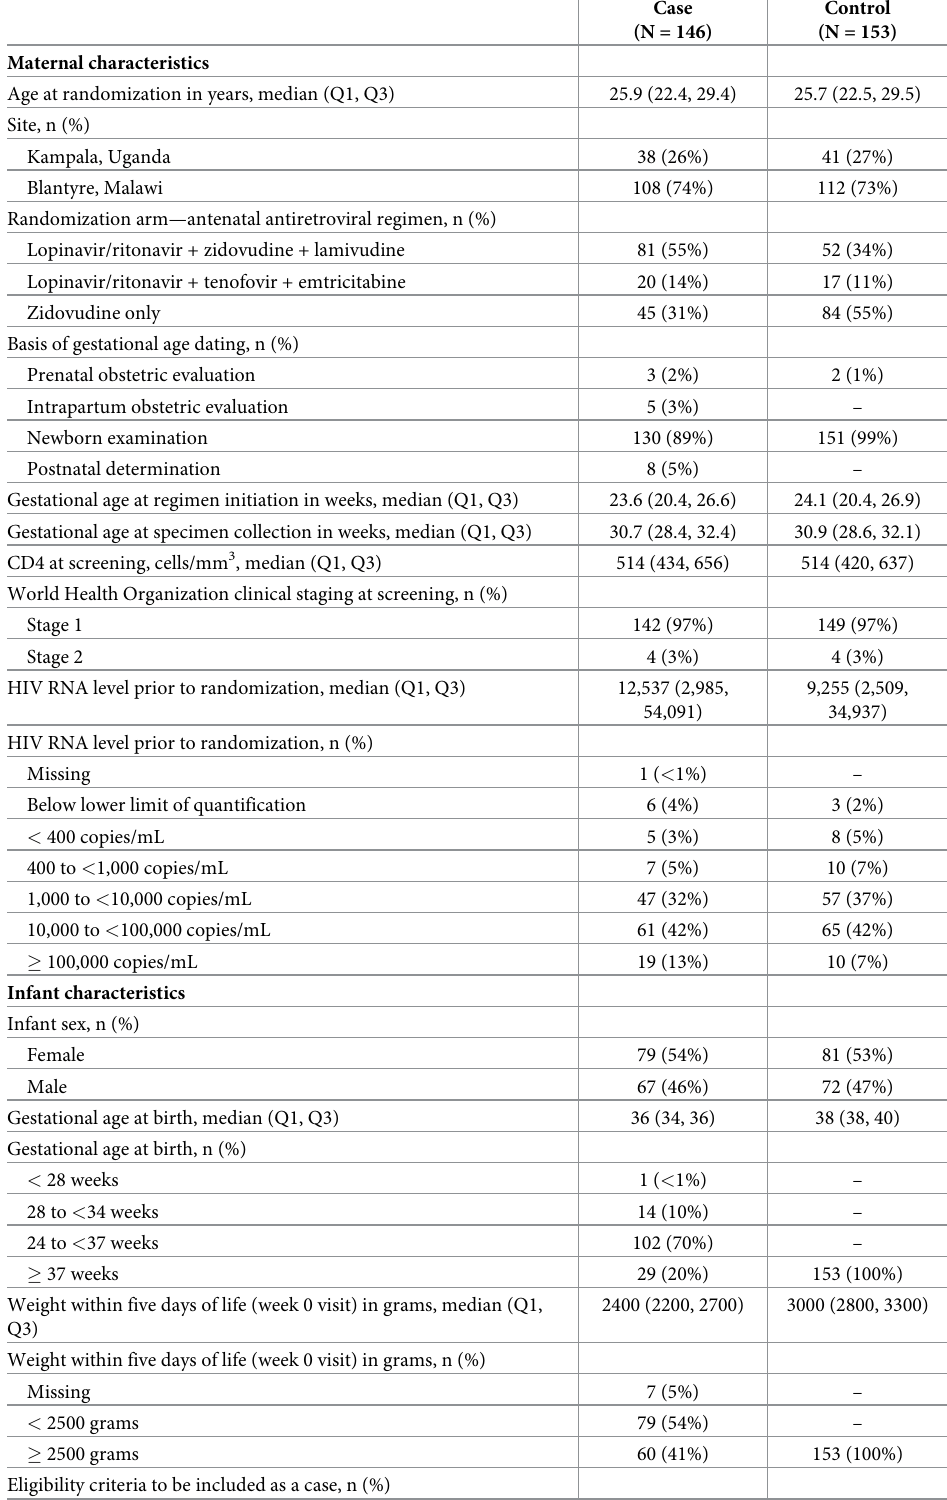
Table 1. Baseline maternal and infant characteristics for mother-infant pairs included in this